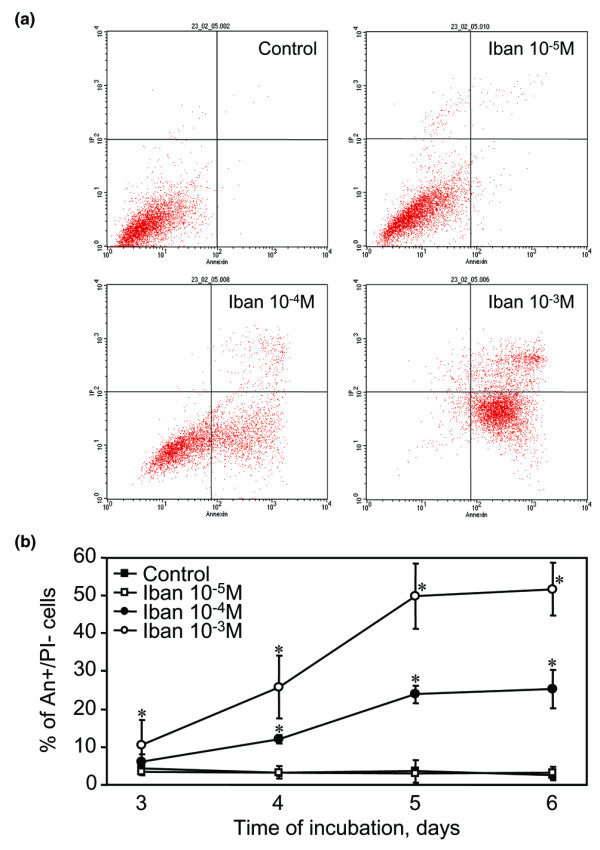
Ibandronate-induced apoptosis in MCF-7 cells assessed by annexin-V fluorescein isothiocyanate and propidium iodide double staining (An/PI). Cancer cells were cultured for three to six days in steroid-free medium containing ibandronate (Iban) or vehicle (control). Apoptotic cells were detected as An+/PI- cells, while viable cells were An-/PI- cells and necrotic cells were PI+. (a) Representative dot plots after five days of Iban exposure. (b) The percentage of An+/PI- cells was determined from three experiments (mean ± SD). Statistical analysis on log transformed data; asterisks indicate ANOVA p < 0.01 versus corresponding control, Dunnett post hoc test.